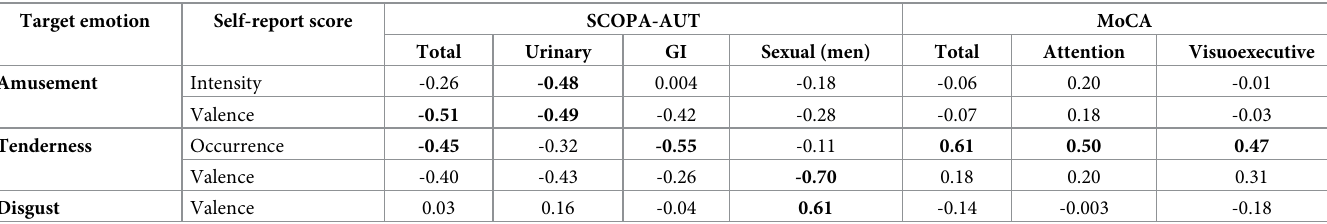
after adjusting for multiple comparisons by controlling for the false discovery rate at q -value < 0.1 appear in bold red style. Besides the MoCA items specified, Tenderness occurrence also correlated significantly with the Attention and Visuospatial indexes (Spearman R = 0.39 and R = 0.41, respectively). Higher and lower scores indicate more severe symptoms for the SCOPA-AUT and MoCA scales, respectively. GI: Gastrointestinal; MoCA: Montreal Cognitive Assessment scale; SCOPA-AUT: Scales for Outcomes in Parkinson’s